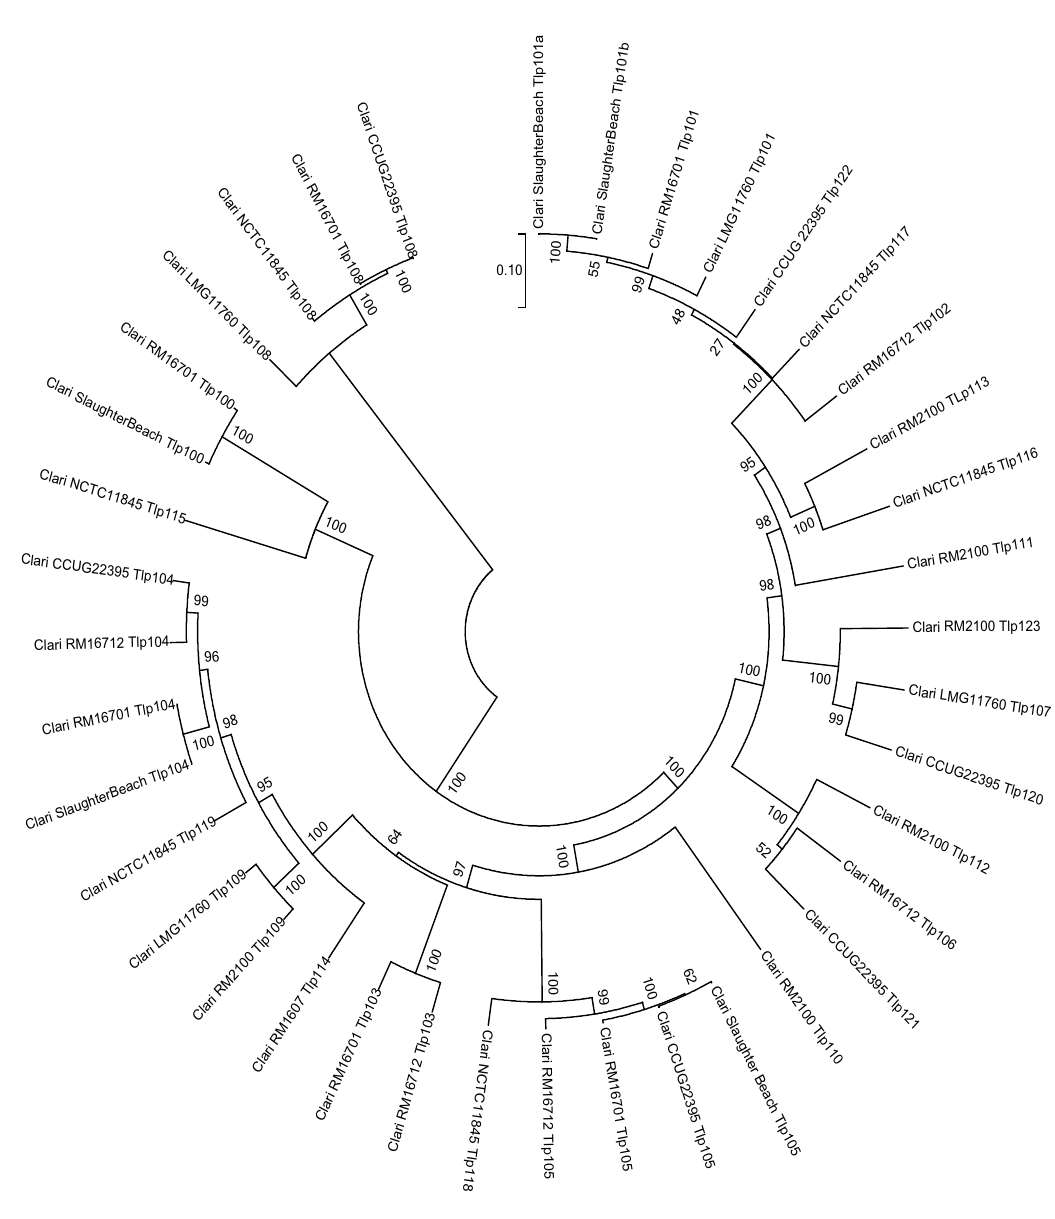
Fig 2. UPGMA dendrogram comparing all Tlp proteins detected in the seven Cl strains investigated.